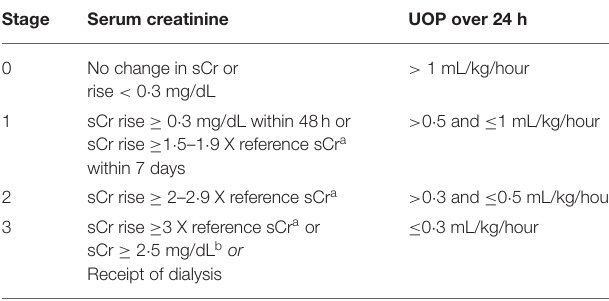
TABLE 1 | Neonatal AKI KDIGO definition.